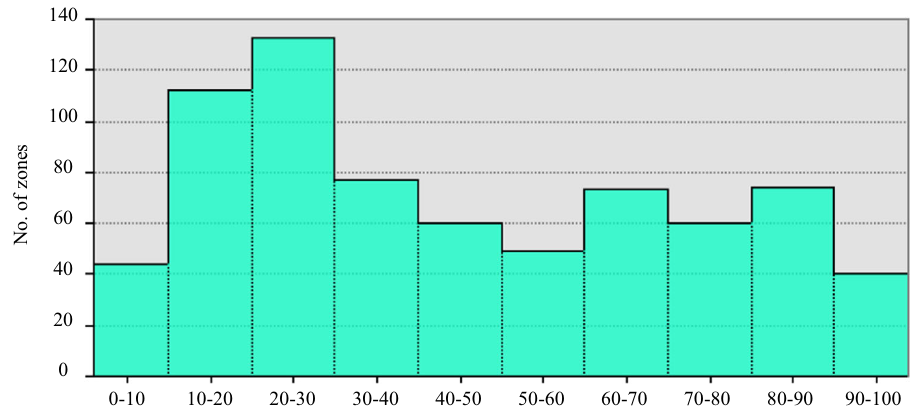
Fig. 6 Case I histogram